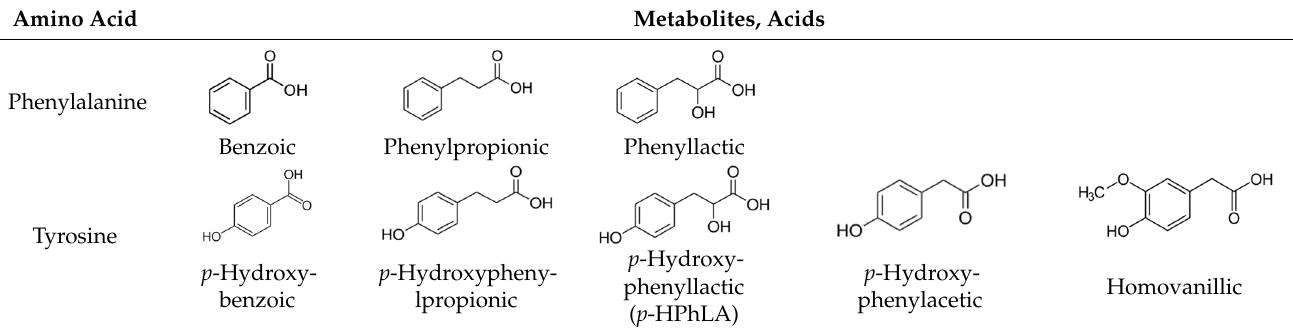
Table 1. Chemical structures of the aromatic acids, which are the metabolites of phenylalanine and tyrosine.